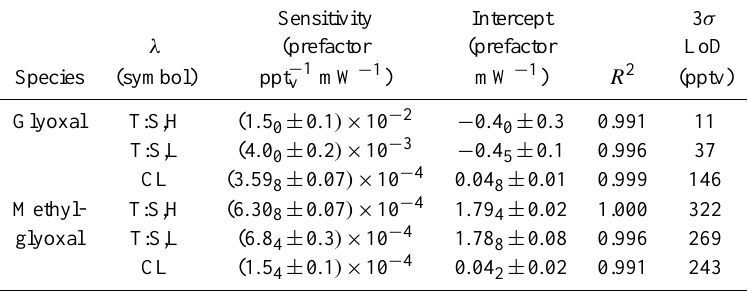
Table 2. Summary of the results from the six different calibrations with only either glyoxal or methylglyoxal present inside the detection cell. All data presented here is 5 min integration. Data taken at λ CL has been scaled from 15min integration to 5min for purpose of comparison. For purposes of comparison, Mad-LIP has an extrapolated 3 σ LoD of 1pptv per 5 min.